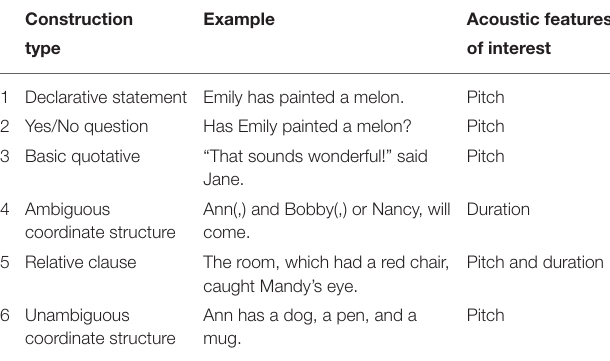
TABLE 2 | Examples of sentence stimuli and associated acoustic features of